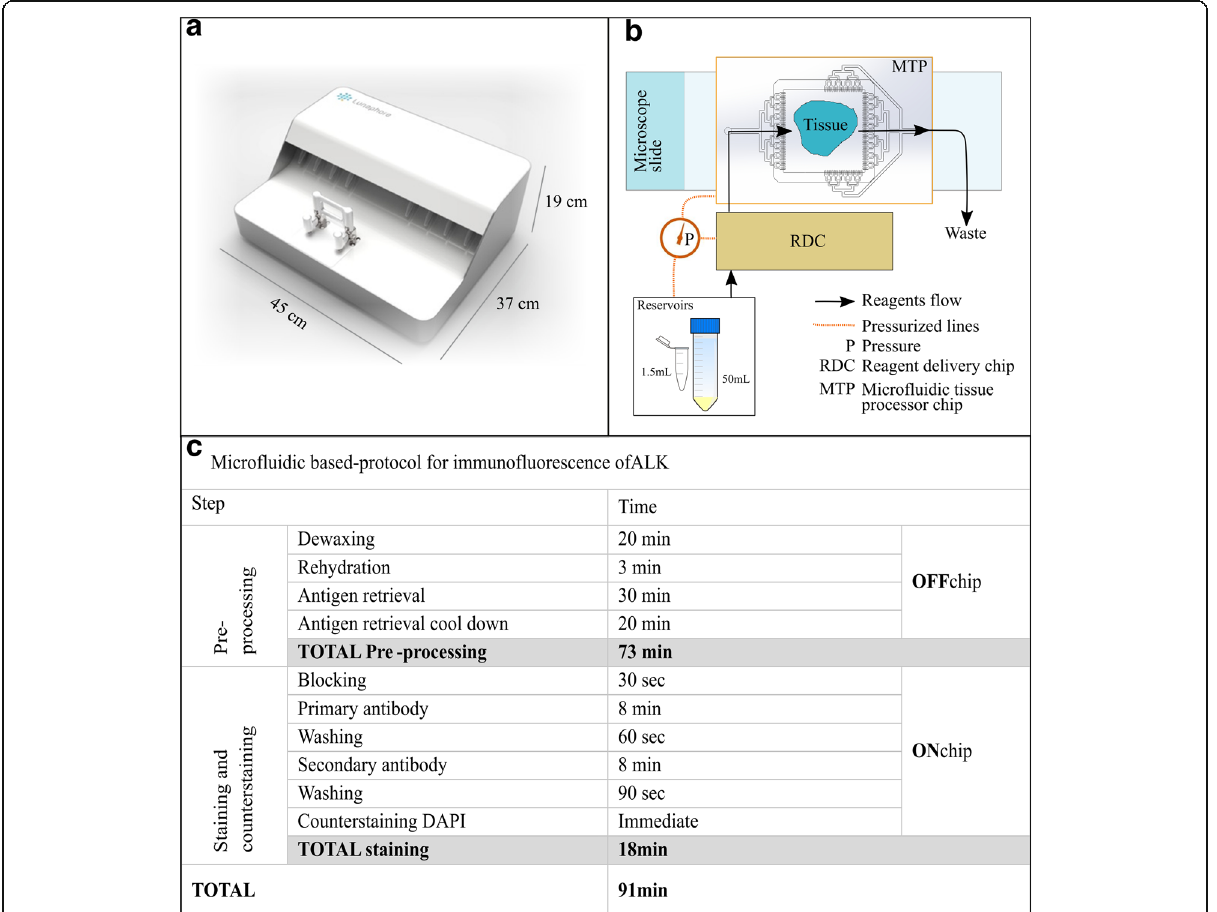
Fig. 1 Working principle of the microfluidic tissue processor (MTP) and detailed time protocols. a-b The MTP device is based on a pressure-driven system, which controls the delivery of the reagents from reservoirs of either 1.5 or 50 mL. Reagents are driven to the tissue slide by passing through the reagent delivery chip (RDC) and the microfluidic tissue processor chip (MTP). The MTP chip is placed on top of the tissue section, resulting in the formation of a thin closed reaction chamber. This allows for confined epitope-antibody interaction. The exchange of reagents is done in a timeframe of 1 s, following the principle of the fast-fluidic exchange technology (FFEX). Thereafter, reagents are delivered into the waste. The clamping of the slide and the protocols details are defined via a user interface connected to the system. c The tissue slide pre- processing was performed manually (OFF chip) and included (i) dewaxing for 10 min at 65 °C followed by 10 min incubation with dewaxing solution, (ii) rehydration with decreasing concentrations of ethanol down to tap water, (iii) heat-induced antigen retrieval with TRIS/EDTA pH 9 at 95 °C for 30 min and (iv) cool-down for 20 min. The direct ALK IF staining was performed on the microfluidic device (ON chip) by using the primary antibody mouse anti-human ALK (Novocastra, clone 5A4) and a fluorescently-labelled secondary anti-mouse IgG antibody (Alexa Fluor 647). The blocking solution was 2.5% horse serum. DAPI was included in the mounting solution for